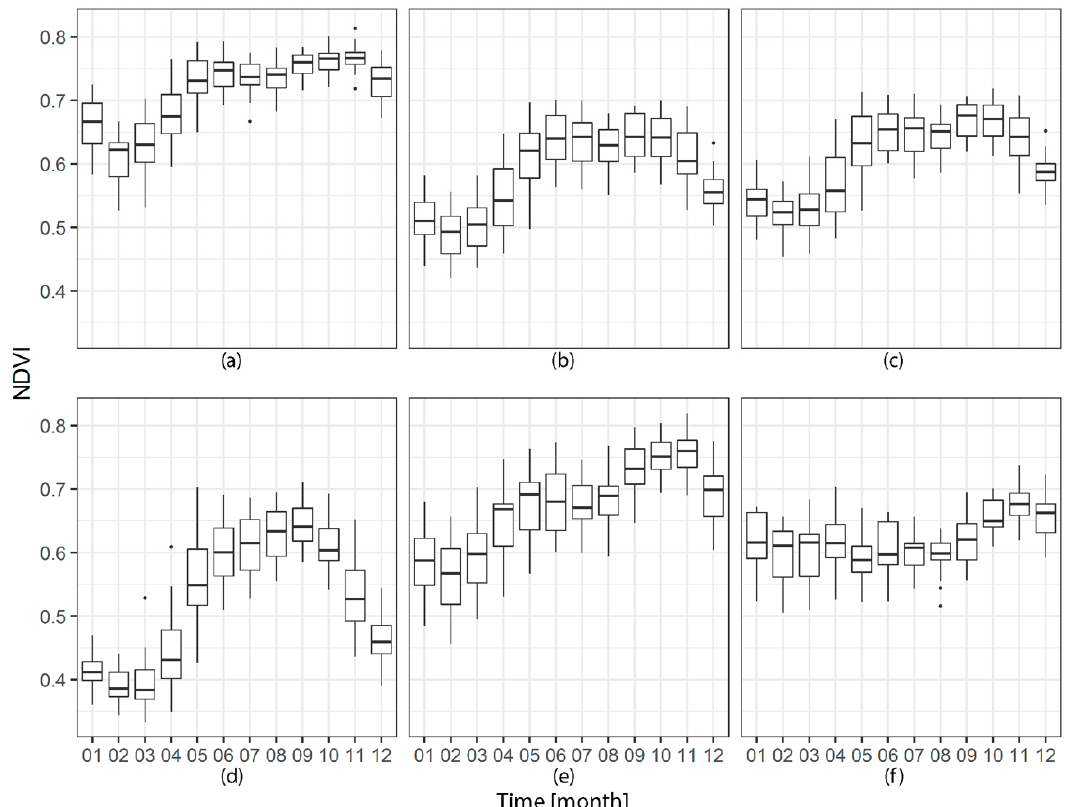
Figure 5. Boxplot of mean monthly NDVI values in Biobio from 2001 to 2020 for the agro-climatics areas: ( a ) Secano Costero, ( b ) Secano interior, ( c ) Depresión Intermedia, ( d ) Cordón Isla, ( e ) Precordillera and, ( f ) Cordillera.